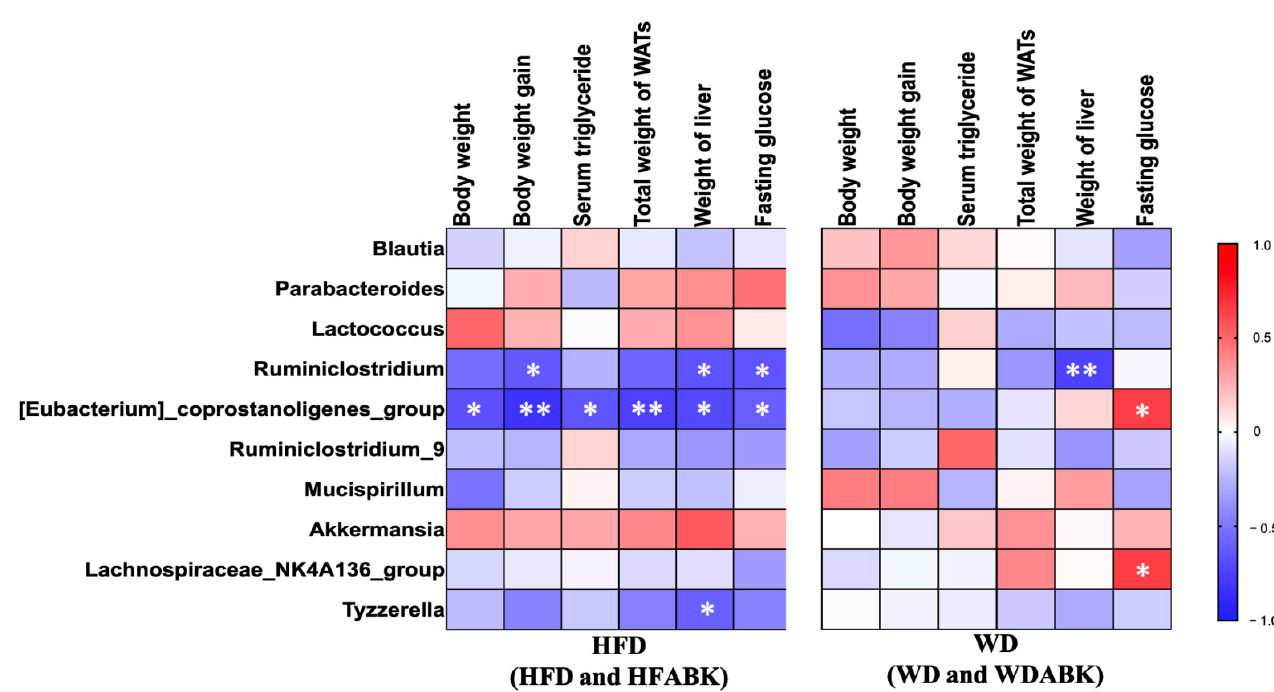
Figure 8. Spearman’s rank correlations between the top ten abundant bacterial genera and obesity-related parameters within HFD-fed mice (HFD and HFABK, n = 12) and WD-fed mice (WD and WDABK, n = 12). Spearman’s correlation analysis with an R value > 0.4 indicates a positive correlation (red color) and a value < − 0.4 indicates negative correlation (blue color). * p < 0.05, ** p < 0.01.